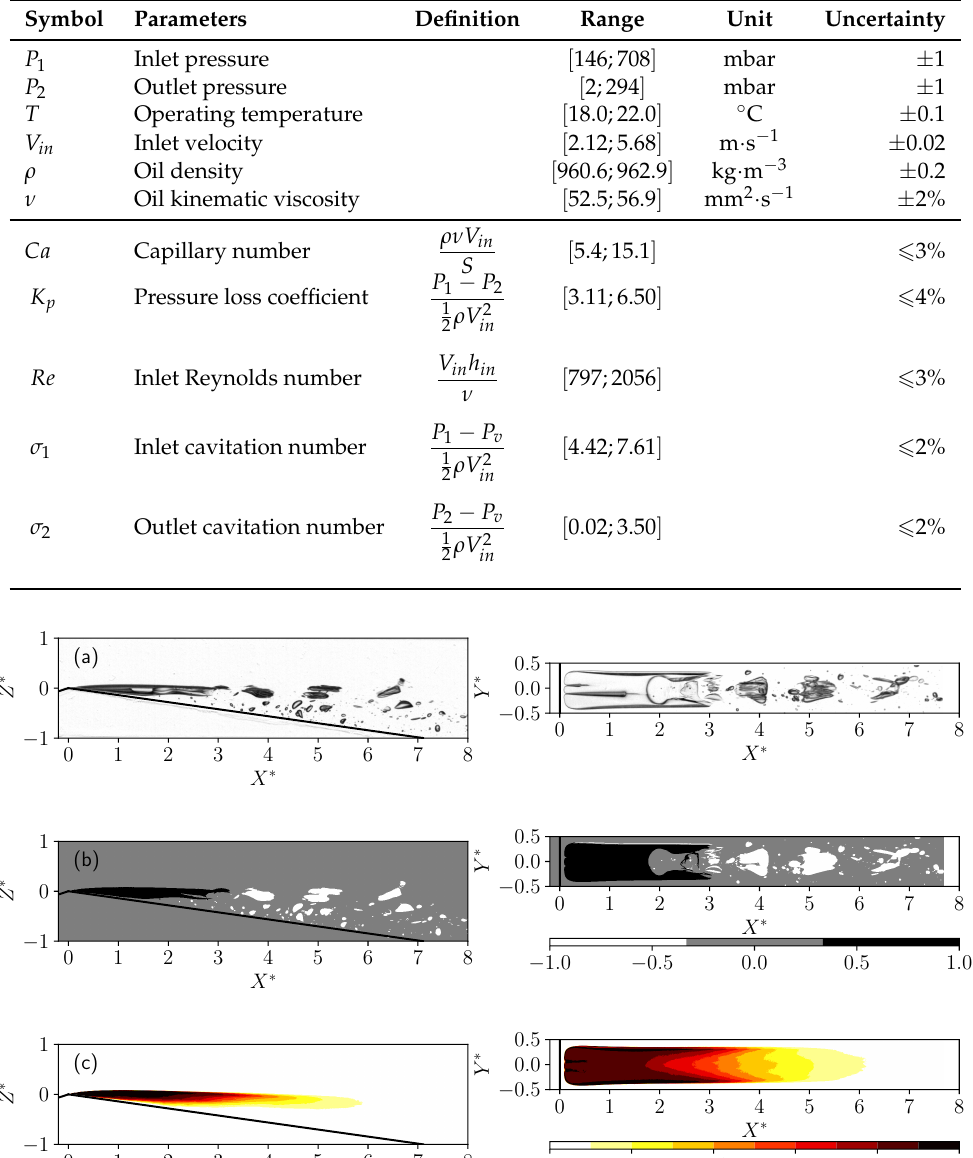
1.3 Pa according to the oil data file. (cid:39)